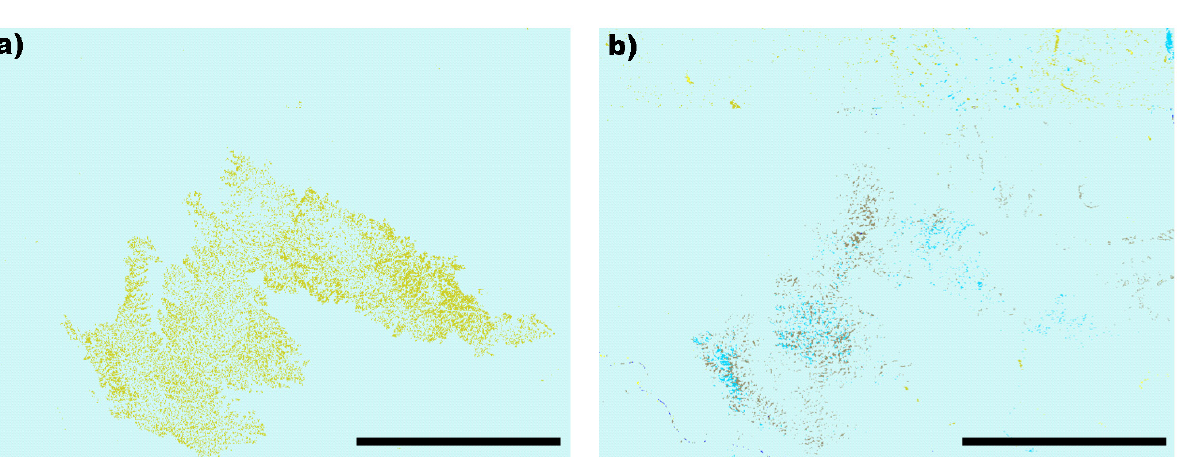
Figure 10. ( a ) Melack and Hess classification, where yellow and off-yellow indicate maximum extent of flooded herbaceous vegetation; ( b ) ALOS classification, where dark blue and medium blue indicate maximum extent of open water and yellow and off-yellow indicate always or occasionally flooded vegetation, respectively. The flooded herbaceous classes tend to be classified as open water (and sometimes as not inundated) in the ALOS classification. (center coordinates: − 1.978°, − 53.708°, shown by letter “w” in Figure 3. The black bar indicates 50 km scale).